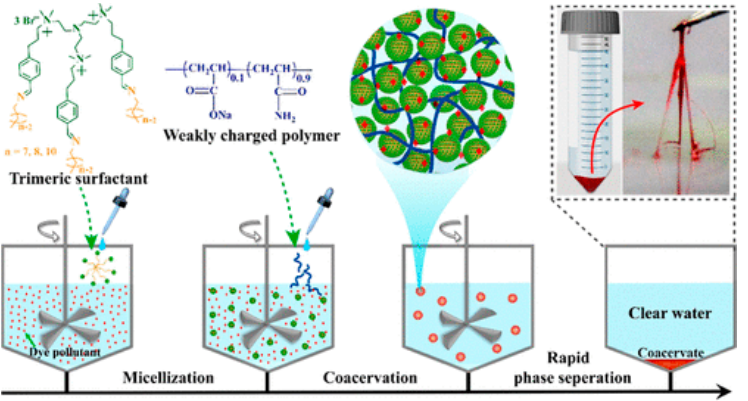
Figure 14. Schematic presentation of trimeric-surfactant-based coacervates for the removal of environmental pollutants. Reprinted with permission from Langmuir , 2021, 37, 5993. Copyright 2021 American Chemical Society.